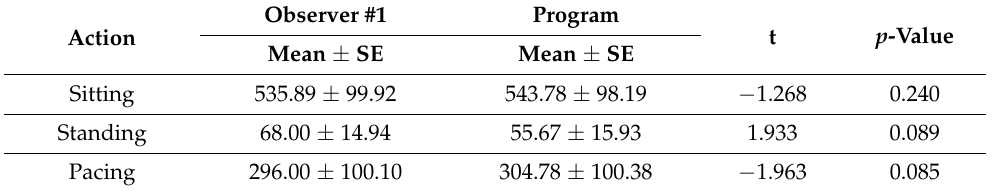
Table 2. Comparison of the measurement analysis between the automated program and the observer #1.